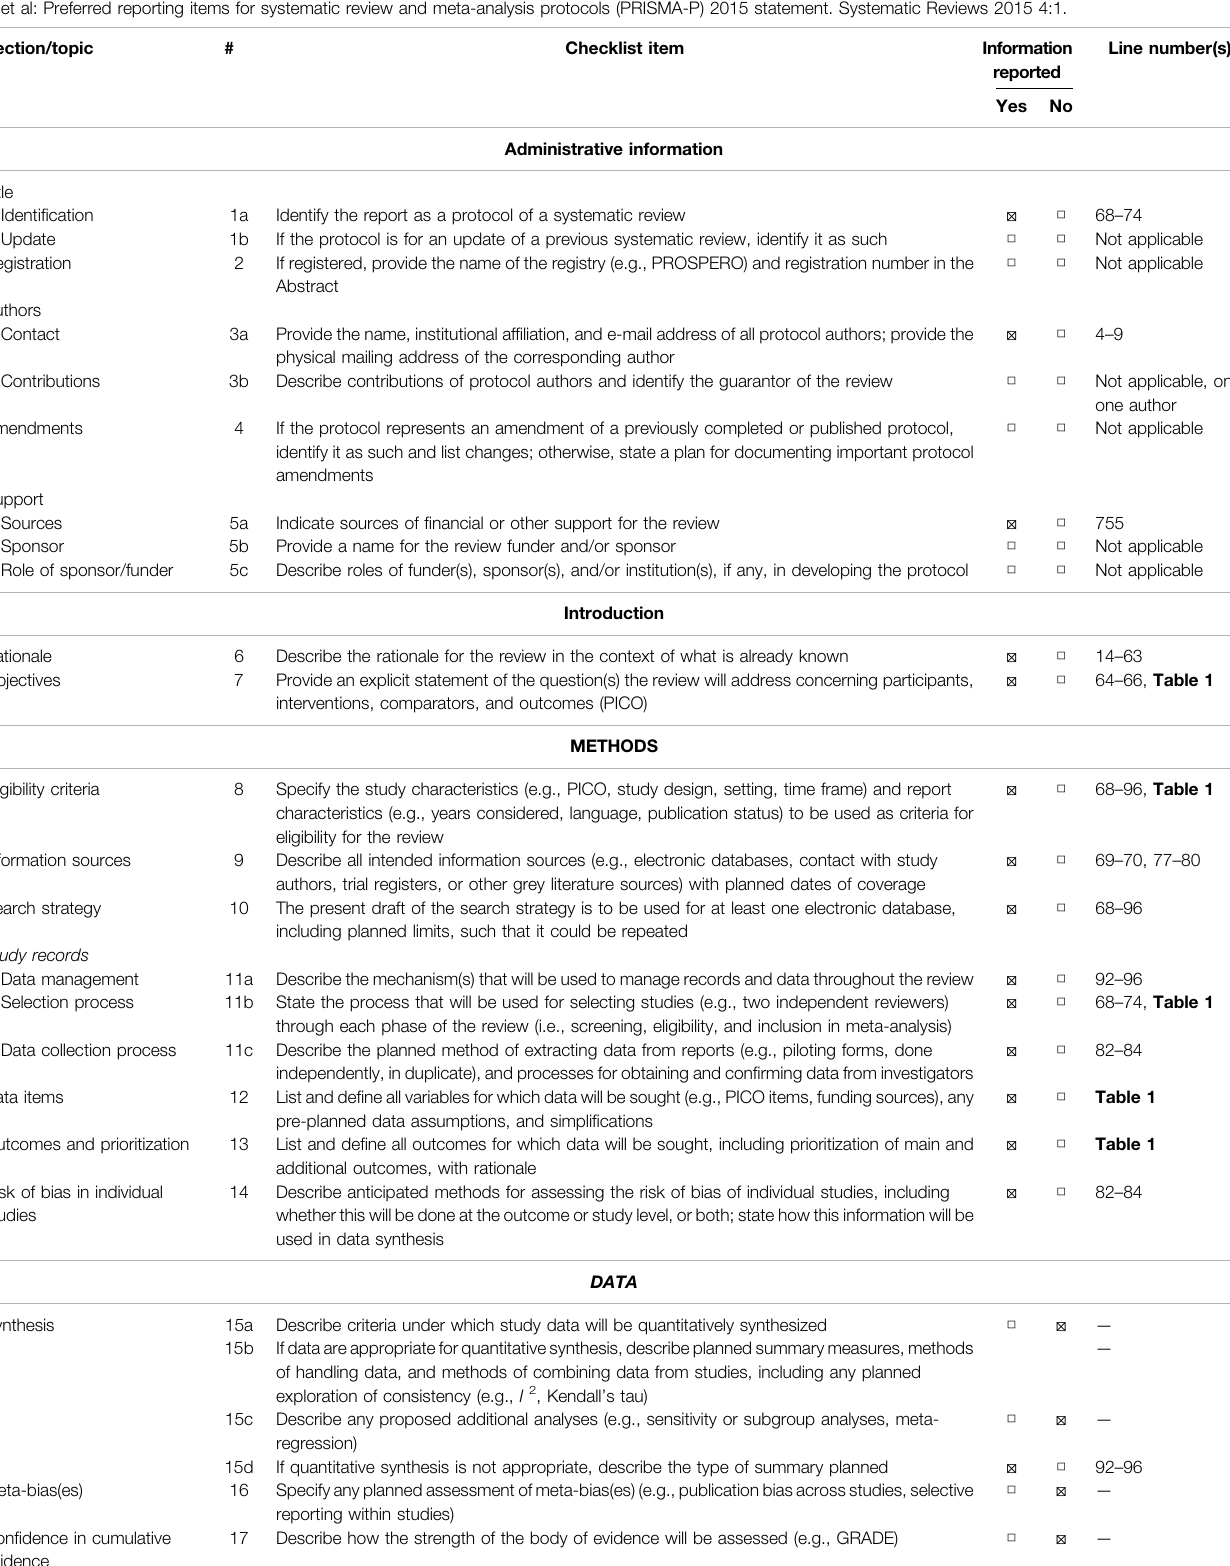
TABLE 2| PRISMA-P 2015Checklist (Moher et al.,2015).Thischecklist hasbeenadapted forusewithprotocolsubmissionstoSystematicReviewsfrom Table 3 inMoher D et al: Preferred reporting items for systematic review and meta-analysis protocols (PRISMA-P) 2015 statement. Systematic Reviews 2015 4:1.